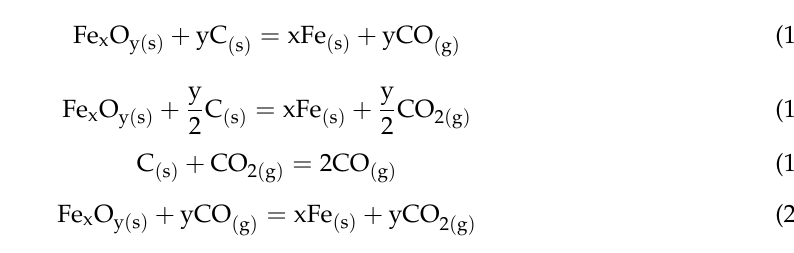
( b ) EDS Figure 9. SEM analysis of Brazilian mineral powder under the condition of carbon powder coating. Figure 8 reveals that after the addition of carbon powder coating, a large number of small balls with compact diameters of less than 1 µm were formed on the surfaces of the Brazilian mineral powder, and were determined to be metallic iron via energy spectrum analysis. As compared with the uncoated carbon powder, the coated carbon powder easily allowed the precipitated metal iron to grow around the carbon powder and form nanoscale-sized metal balls, which could inhibit the formation of iron whiskers, reduce the bond force of iron powder, reduce the sticking ratio of the reduced ore powder, and improve the fluidization reduction state. 4. Conclusions The conclusions arising from this work can be summarized as follows: 1) Under carbon powder coating conditions, the metallization rate can be increased, the fluidization state can be improved, and the adhesion ratio can be reduced by properly increasing the pressure; 2) The best operating parameters of the coated toner were as follows. The temperature was selected to be 923–1023 K, the reduction gas velocity was selected to be 0.6 m/s, the reduction time was selected to be 30–50 min, the reduction pressure was selected to be 0.25 MPa, the particle size of the toner particles was selected to be 4–7 µm, and the toner content was selected to be 2–6%; 3) The agglomeration of iron whiskers is the main reason for the adhesion of iron powder particles. The carbon powder coating was found to effectively change the morphology of iron